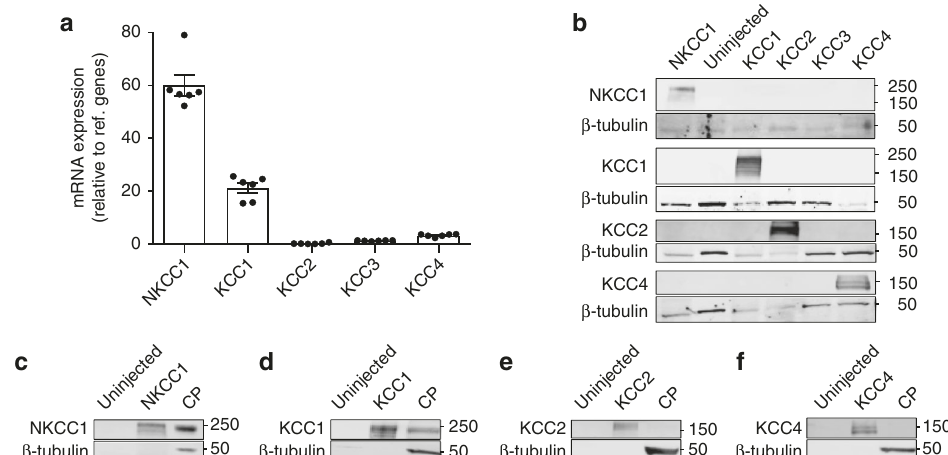
Fig. 2 NKCC1 and KCC1 are expressed in mouse choroid plexus. a mRNA expression levels of NKCC1 and the four KCC isoforms in mouse choroid plexuses. The fi ve target genes were normalized to two reference genes, GAPDH and H2AFZT, and presented as relative expression; NKCC1 = 60.0 ± 3.9, KCC1 = 21.2 ± 1.8, KCC2 = 0.2 ± 0.1, KCC3 = 1.2 ± 0.1, and KCC4 = 3.2 ± 0.2 ( n = 6 mice), error bars represent standard error of the mean. b Representative western blots to verify antibody speci fi city. NKCC1 and KCC1-4 were expressed in Xenopus laevis oocytes and puri fi ed membranes from these and uninjected oocytes were exposed to SDS-PAGE followed by western blot ( n = 3 experiments). c − f Western blots of lysates from mouse choroid plexus demonstrated expression of NKCC1 ( c ) and KCC1 ( d ), while KCC2 ( e ) and KCC4 ( f ) were not detected. Beta-tubulin was employed as